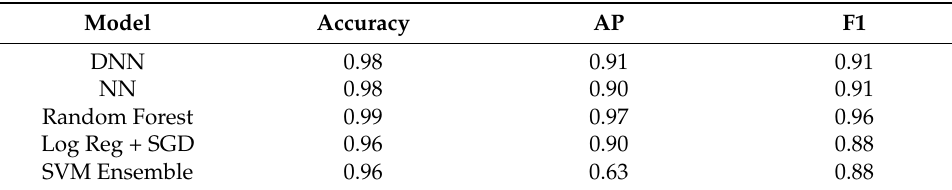
Table 2. Classification report results. Random Forest achieved the highest F1 and average precision scores. Due to class imbalances, F1 and AP are considered the primary evaluation metrics. Random Forest is therefore used for final predictions.